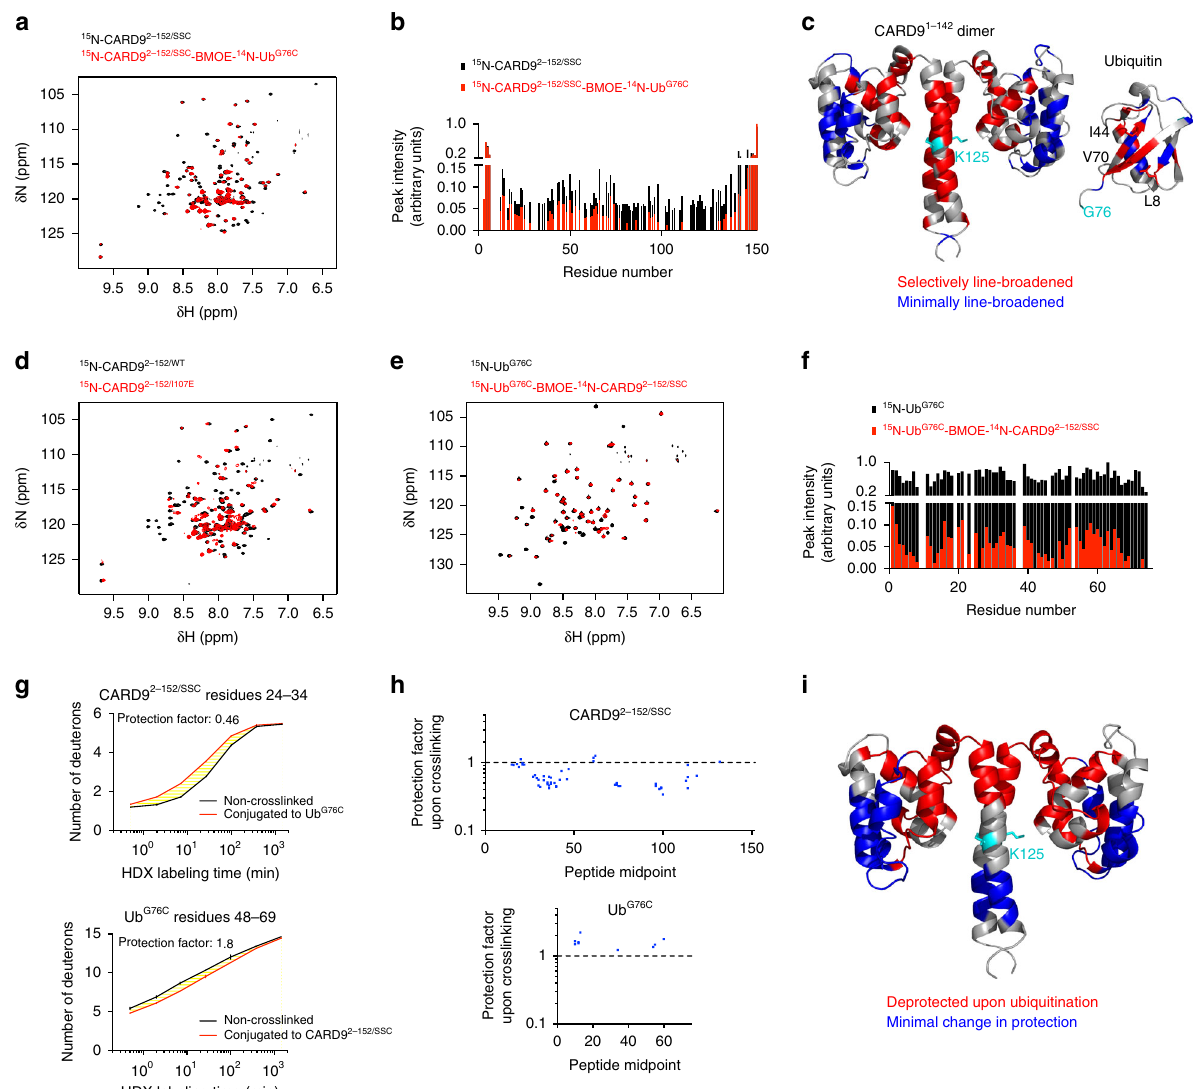
Fig. 4 Ubiquitination of CARD9 at Lys125 disrupts the CARD-coiled-coil interface. a 15 N-TROSYs of CARD9 2 − 152/SSC apo (black) or conjugated to 14 N-Ub G76C (red). b Peak intensities of spectra in a for all assigned, non-overlapped peaks. c Lowest energy CARD9 2 − 142 dimer structure (left) and ubiquitin crystal structure (PDBID 1UBQ [http://dx.doi.org/10.2210/pdb1UBQ/pdb], right). Selectively line-broadened residues (<25% apo intensity for CARD9 2 − 142 and <5% apo intensity for ubiquitin) are colored red. Minimally line-broadened residues (>50% apo intensity for CARD9 2 − 142 and >10% apo intensity for ubiquitin) are colored blue. Residues Lys125 in CARD9 2 − 142 and Gly76 in ubiquitin are colored cyan. d 15 N-TROSYs of CARD9 2 − 152/WT (black) and CARD9 2 − 152/I107E (red). e 15 N-TROSYs of Ub G76C apo (black) or conjugated to 14 N-CARD9 2 − 152/SSC (red). f Peak intensities of spectra in panel e for all non-overlapped peaks. g Deuterium exchange as a function of labeling time for representative peptides from CARD9 2 − 152/SSC and Ub G76C unconjugated (black) or conjugated (red). h Global protection factors for CARD9 2 − 152/SSC and Ub G76C after conjugation as compared to apo. Each dot represents the mid-point of a single identi fi ed peptide. Dotted line indicates a protection factor of 1, indicating no change upon conjugation. Values less than one indicate de-protection, i.e., faster deuterium exchange. i CARD9 2 − 142 dimer structure with regions de-protected upon ubiquitination plotted in red and unaffected regions plotted in blue. Lys125 is indicated in cyan. All source data are provided in Source Data fi